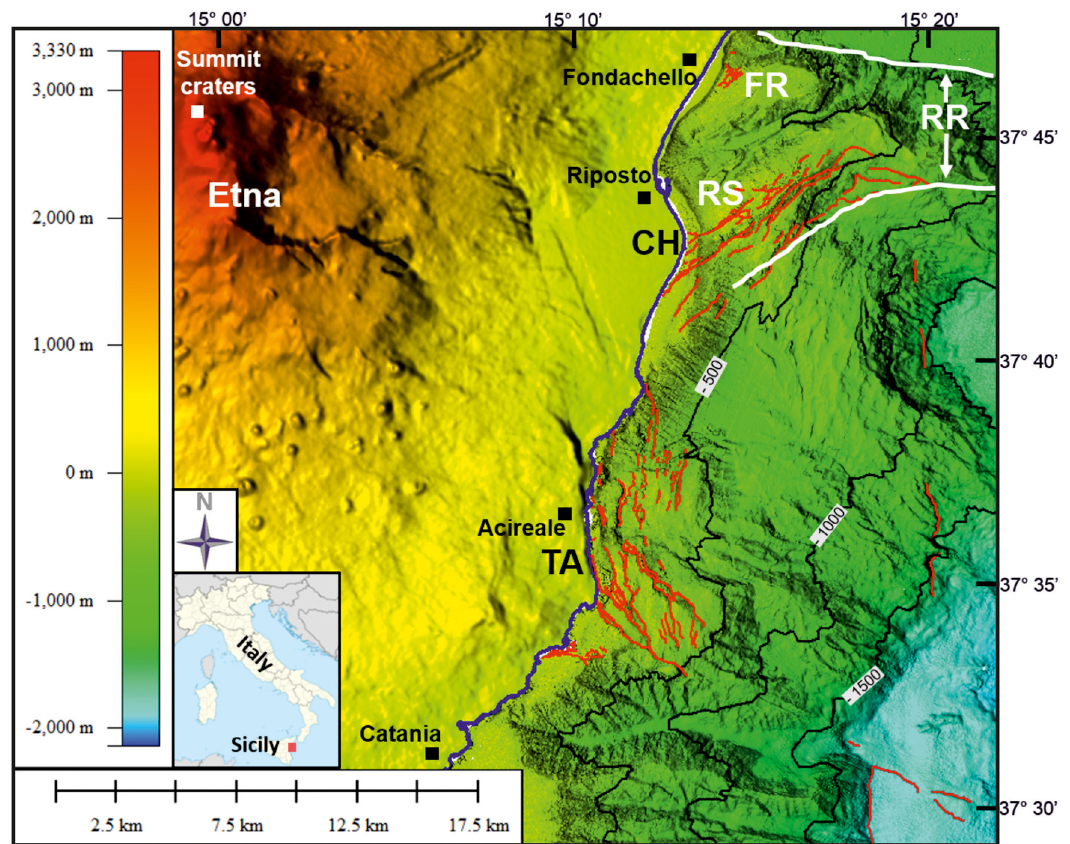
Figure 2. High-resolution bathymetry map (modified from Chiocci et al. [2011]) offshore Mt. Etna with the main interpreted tectonic lin- eaments (red lines); RR: Riposto Ridge (white lines represent its boundaries), FR: Fondachello Ridge, RS: Riposto Shoal, CH: Chiancone vol- canoclastic deposit, TA: Timpa area. The inset displays the study